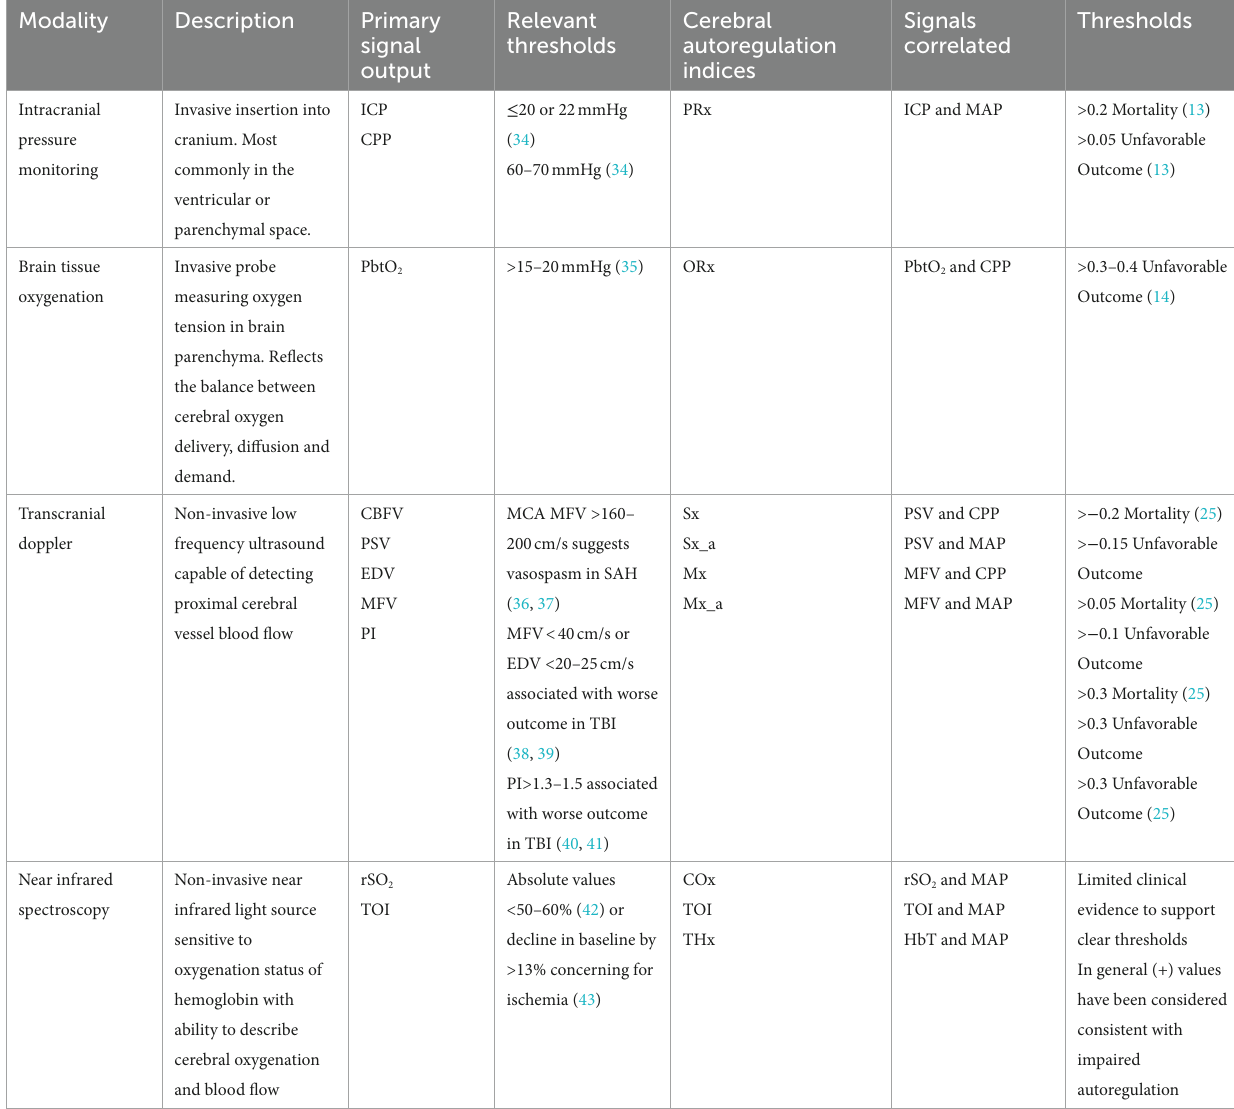
TABLE 1 Neuromonitoring devices, physiologic outputs and autoregulation